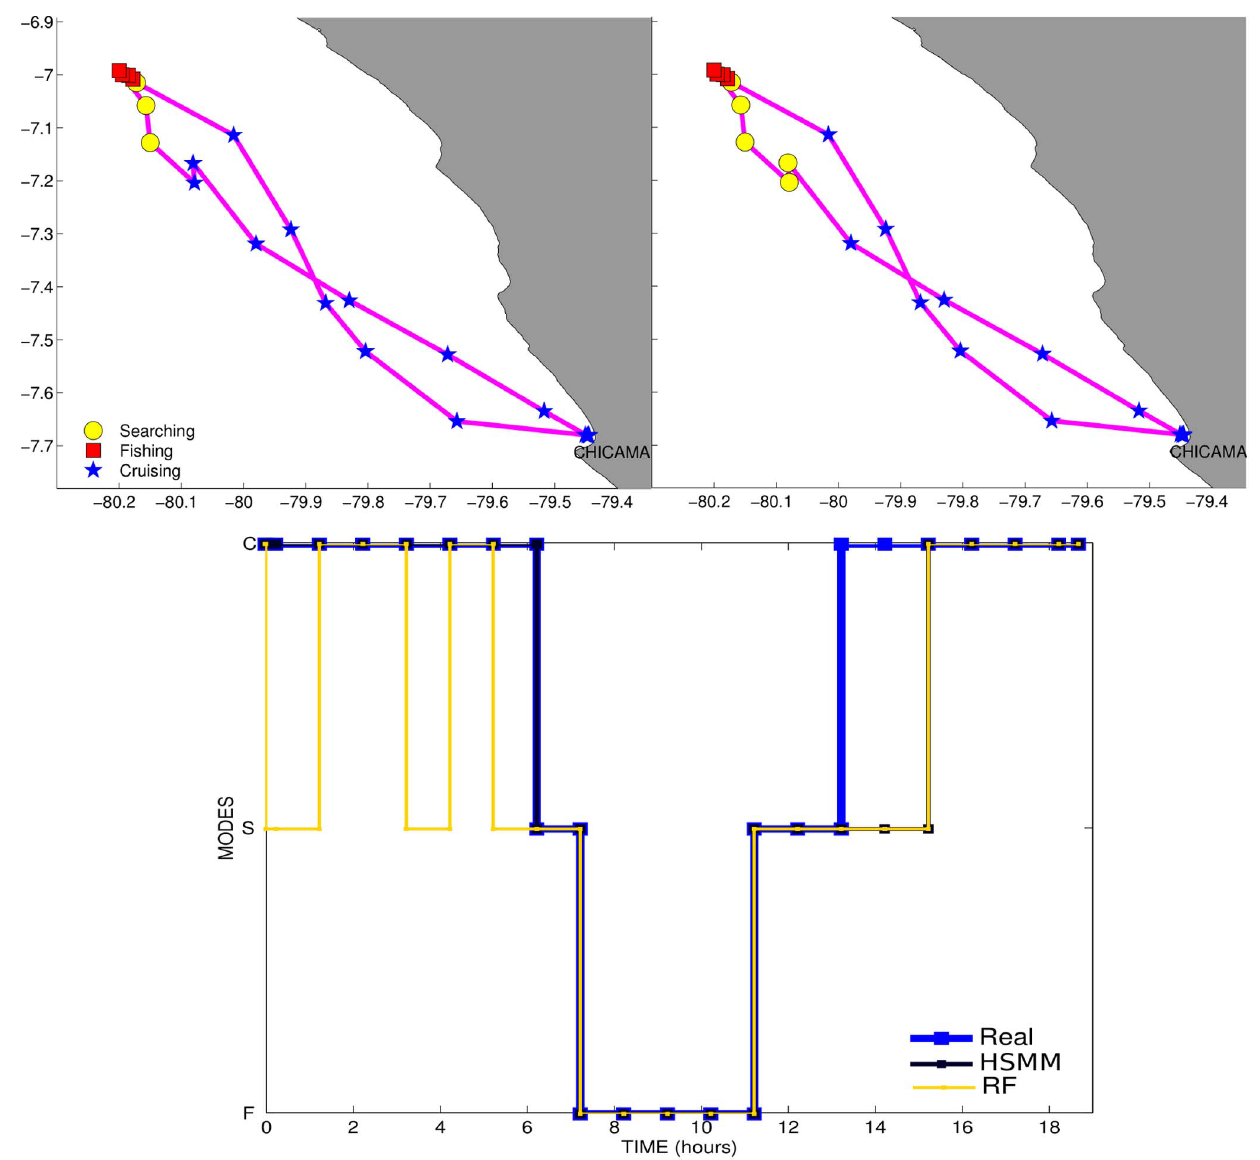
Figure 4. A fishing trajectory. Left upper panel: track with real behavioural modes. Right upper panel: track with inferred modes using the HSMM. Lower panel: temporal representation of the behavioural mode sequences, real and inferred, where 0 in the x-axis represents the beginning of